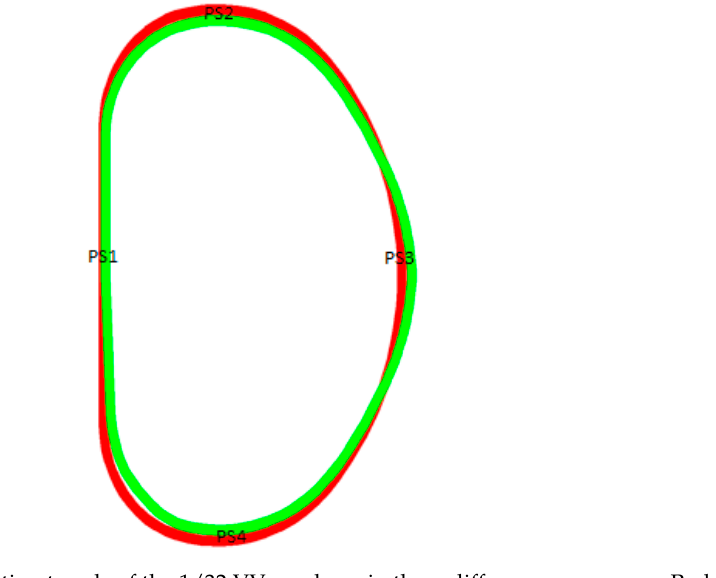
Figure 21. Overall distortion trends of the 1/32 VV mock-up in three difference sequences. Red line represents the initial shape before welding, and the green line represents the distorted shape after welding. PS1, PS2, and PS4 distort to inside perpendicular to the shells and PS3 distorts to outside perpendicular to the shells.